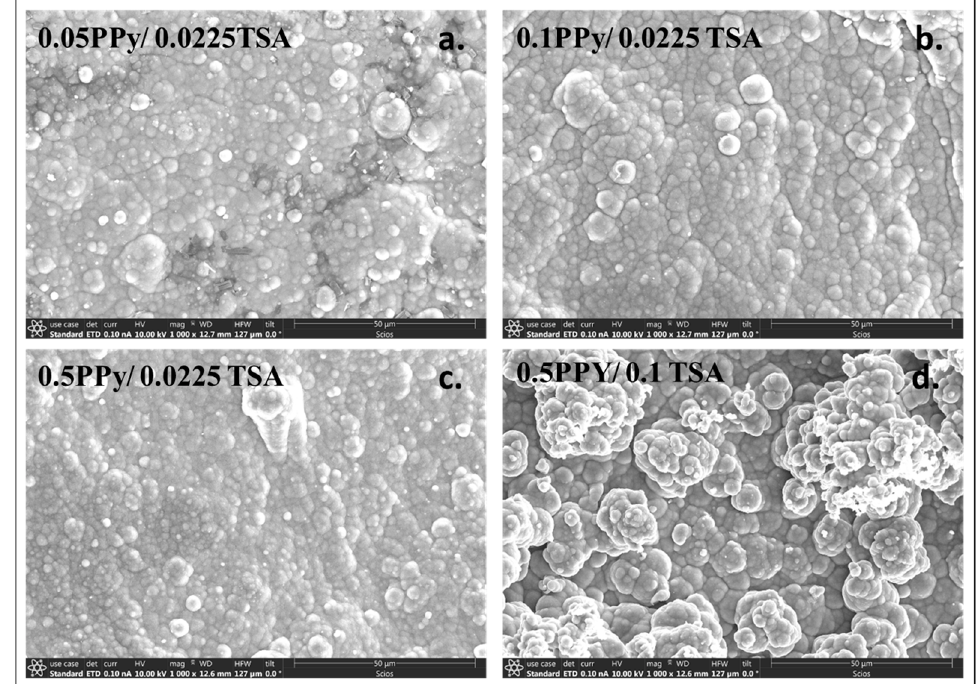
Figure 2. 1000× magnification showing the effect of dopant and Py concentration on PPy deposition and resulting surface morphology.